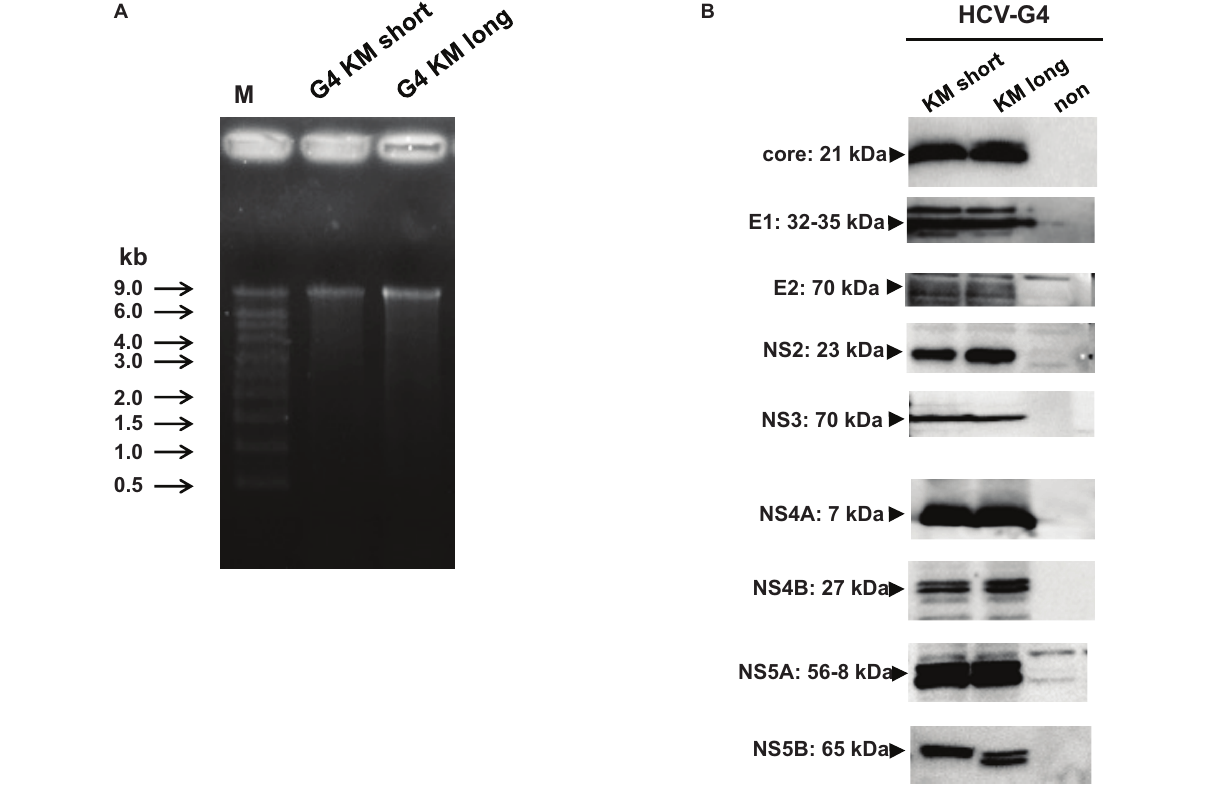
than that obtained with genotype 1a, 1b, 3a, or 6a (10 4 − 6 copies/mL after 6 weeks) (Mercer et al.,